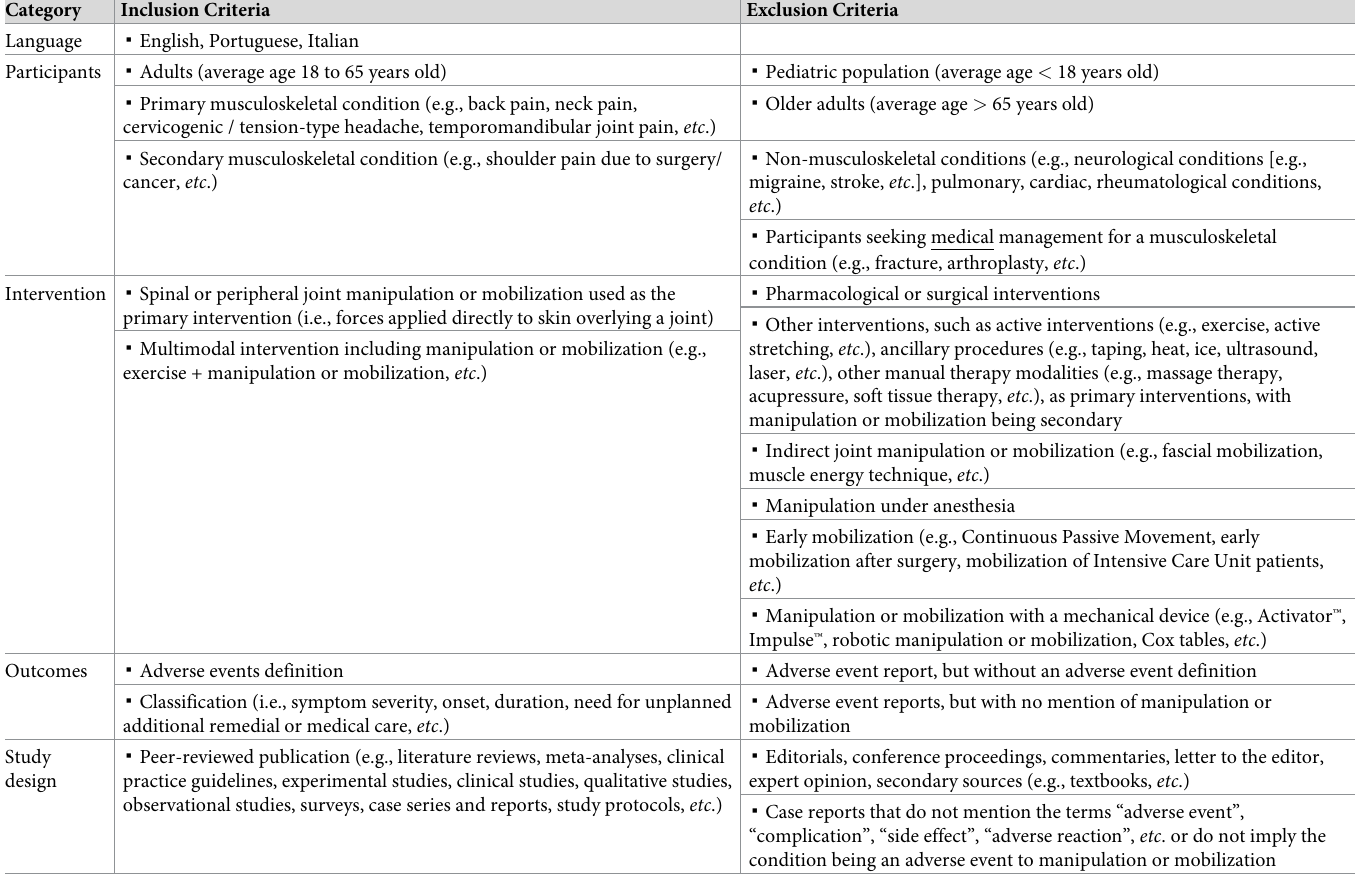
Table 1. Inclusion and exclusion